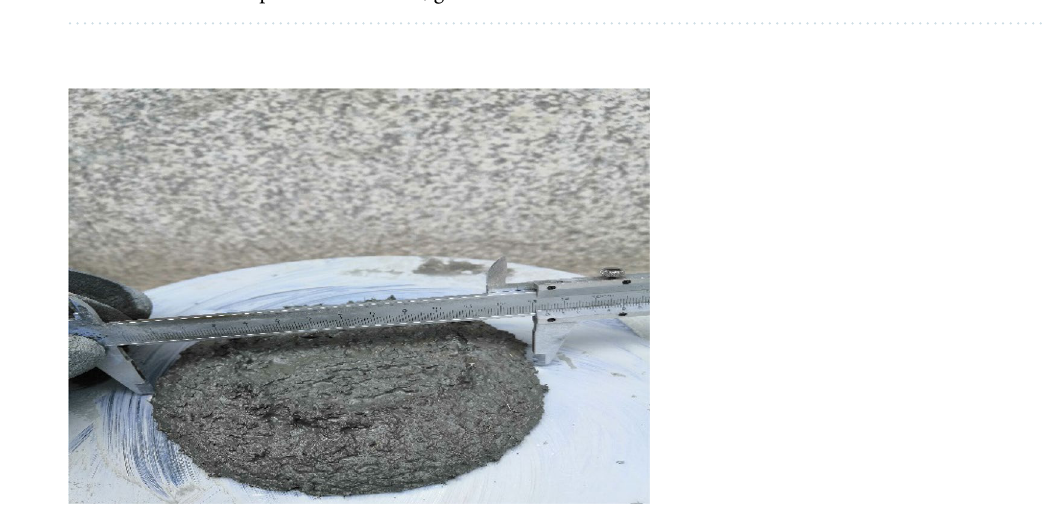
Figure 2. Jumping table